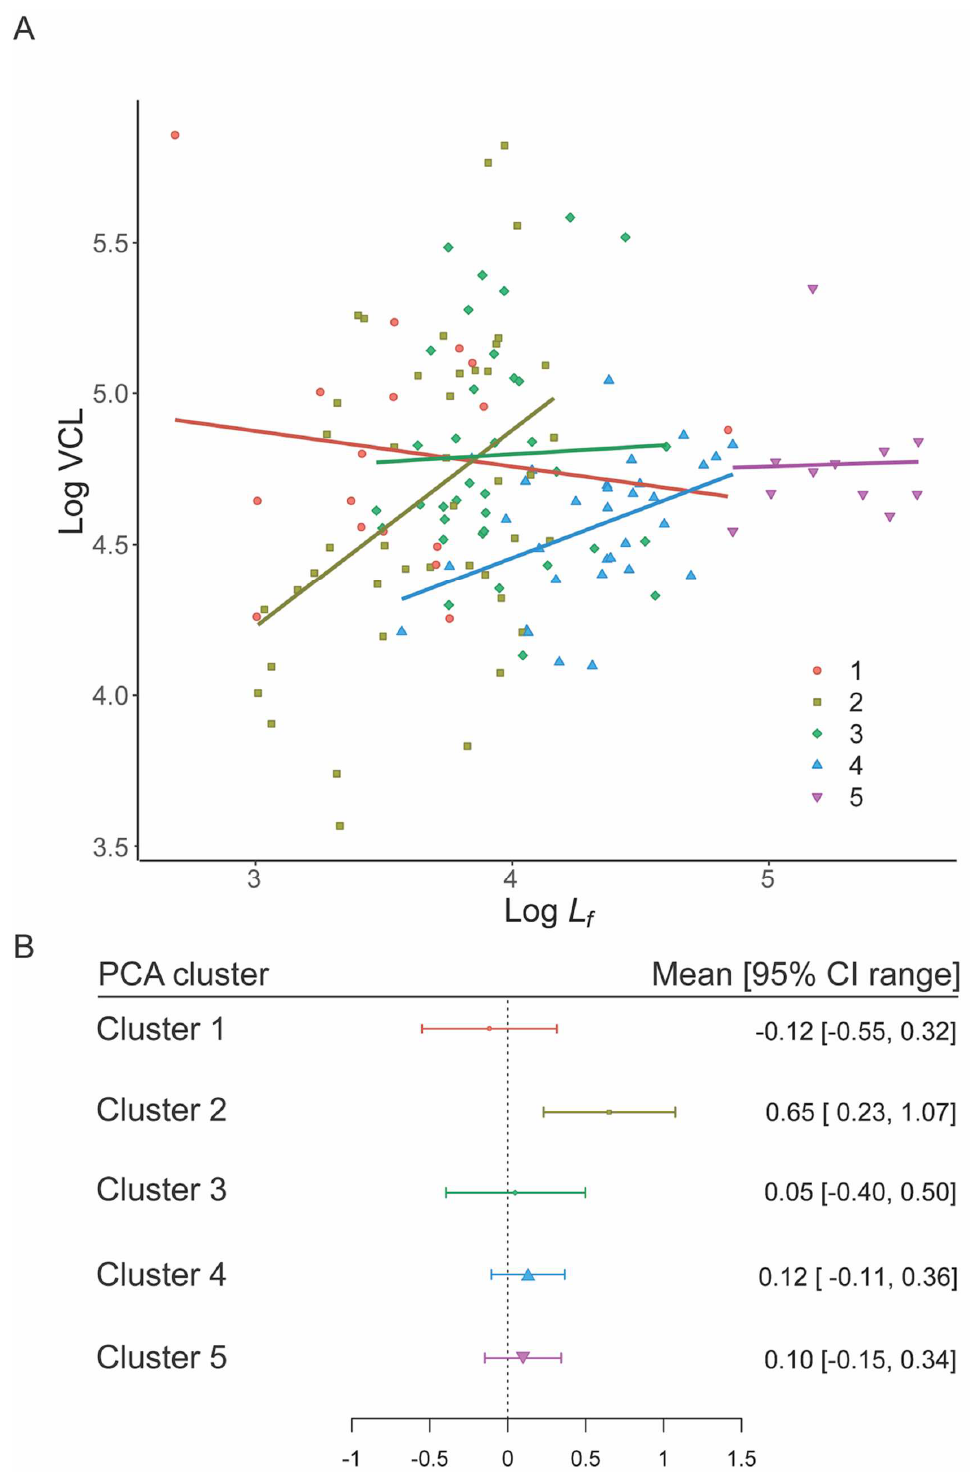
Figure 4. Speed–Flagellum length relationships for the five PCA morphology clusters. ( A ) PGLM slopes for each cluster. ( B ) Distribution of mean and 95% CIs for cluster slopes, point size is propor- tional to n . Only the slope for cluster 2 differs from the expected value of zero (Constant speed model) based on 95% CI overlap.